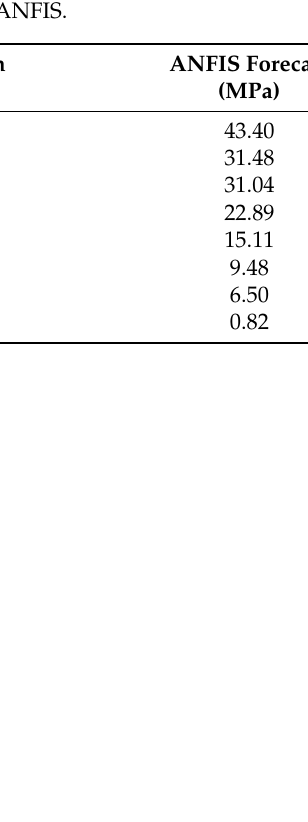
Figure 7. Linear regression between the predicted values versus experimental tensile strength values during testing using the ANFIS model.